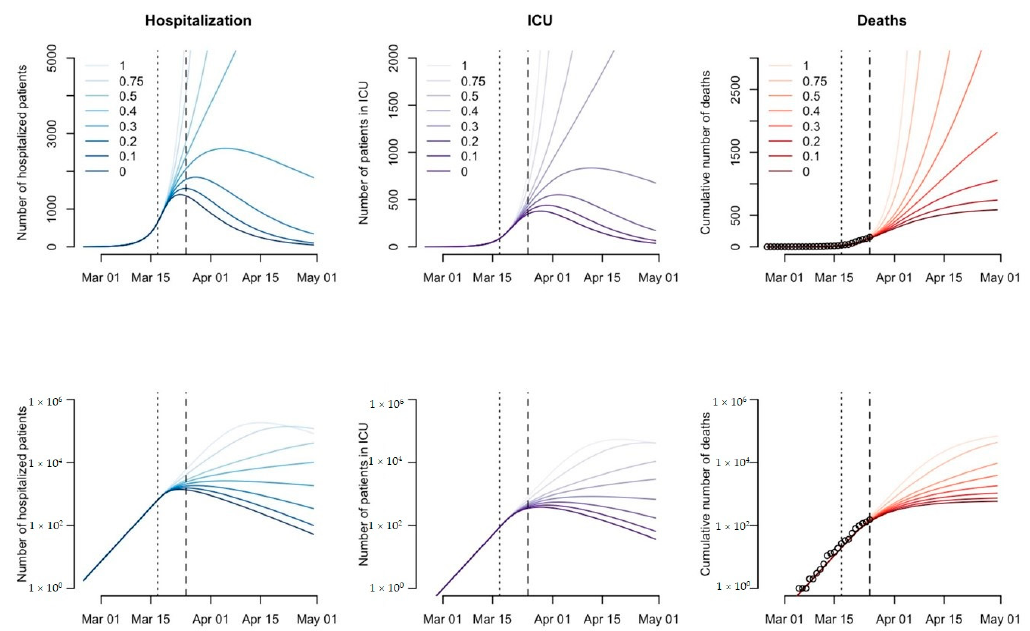
Figure 3. Projected numbers of hospitalizations, patients in ICU, and deaths under di ff erent scenarios for the COVID-19 epidemic in Switzerland shown on a linear scale (top panels) and a logarithmic scale (bottom panels). Vertical dotted and dashed lines indicate the time points of the social distancing measure (17 March 2020) and the last data point (25 March 2020). Source: Althaus, Christian, “Real-time modeling and projections of the COVID-19 epidemic in Switzerland.”